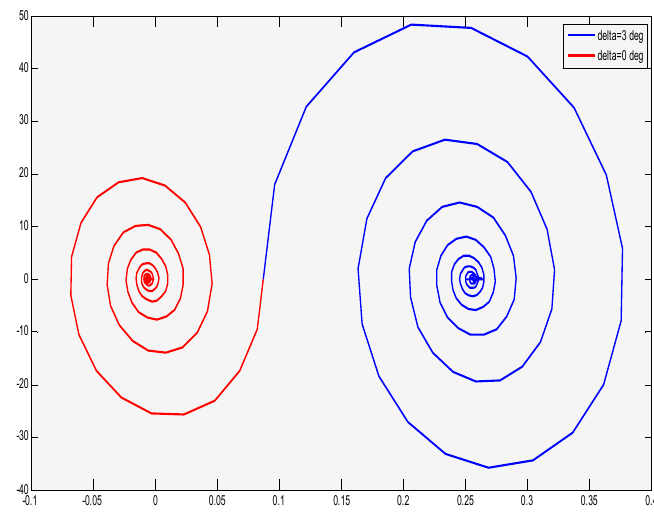
 freeplay. (In flutter speed).